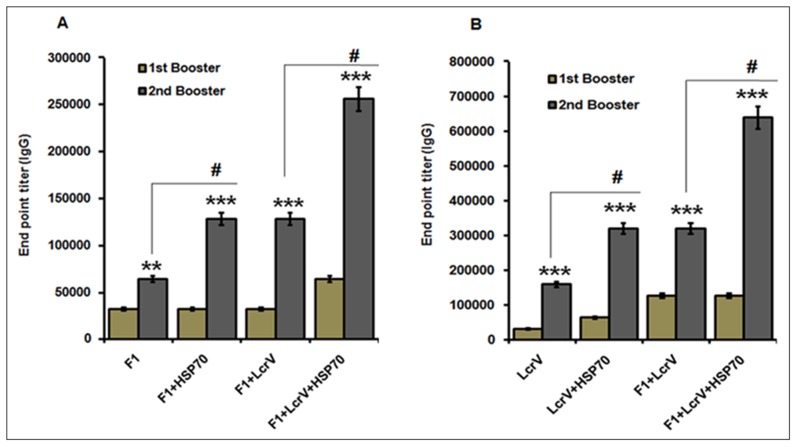
Measurement of serum IgG antibody titers in immunized Balb/C mice.[A] Sera collected after first booster (14th day) and second boosters (21st day) from immunized groups (F1, F1+HSP70(II), F1+LcrV, F1+LcrV+HSP70(II)) were measured for F1-specific IgG by indirect ELISA. [B] Determination of LcrV-specific serum IgG antibody titer in the sera from immunized groups (LcrV, LcrV+HSP70(II), F1+LcrV, F1+LcrV+HSP70(II)). Data are represented in mean antibody titers with SD of eight Balb/C mice in each group. The cut-off value for the assays was calculated as the mean OD (+2 SD) from sera of control group assayed at 1∶100 dilution. Serum endpoint IgG titers were calculated as the reciprocal of the highest serum dilution giving an OD more than the cut-off. Analysis was done by one way ANOVA, All Pairwise Multiple Comparison Procedure (Fisher LSD Method). ** P<0.01; *** P<0.001; # P<0.001.